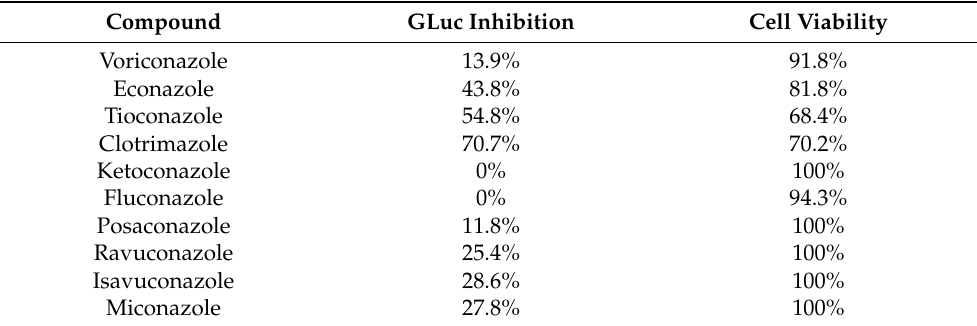
Table 2. Activity of azoles against CHIKV replicon